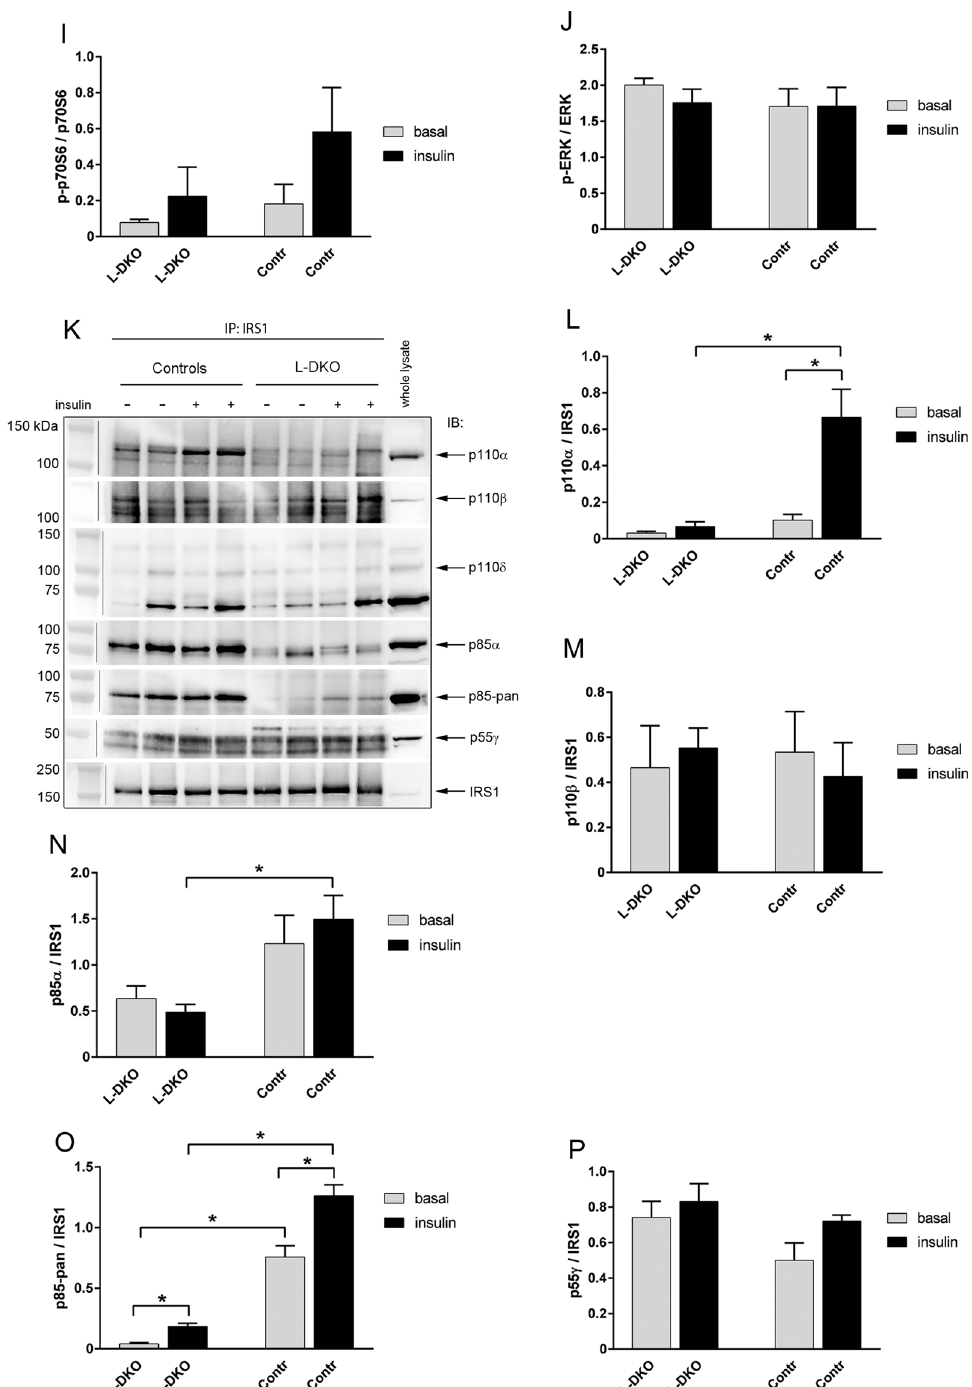
Figure 1. Gene- and protein-expression of regulatory and catalytic subunits of PI3K and associated insulin signaling mediators. mRNA expression of ( A ) Pik3ca , ( B ) Pik3cb , ( C ) Pik3r1 and ( D ) Pik3r2 in livers of flox controls and L-DKO mice. ( E ) Representative western blot of protein expression of p110 α , p110 β , p85 α , p85-pan (detects both p85 isoforms) and p55 γ . Total Akt was used as a loading control. ( F , phosphorylated Akt/PKB (Ser 473 and Thr 308), phosphorylated p70S6 kinase, and phosphorylated ERK in livers of flox controls and L-DKO mice. Total Akt, p70S6K and ERK was used as loading controls. ( G – J ) Quantification measurements of the western blots shown in ( F ) of pS-Akt, pT-Akt, p-p70S6K and p-ERK respectively. ( K ) Representative western blot of immunoprecipitation experiments with antibodies for IRS1 and subsequent immunoblotting with antibodies for p110 α , p110 β , p110 δ , p85 α , p85-pan (detects both p85 isoforms) and p55 γ . The whole-lysate reference sample was from an insulin-treated flox control mouse. ( L – P ) Quantification measurements of the western blots shown in ( K ) of p110 α , p110 β , p85 α , p85-pan and p55 γ . IP = immunoprecipitation, IB = immunoblot. Basal condition is indicated with a minus (-) sign, insulin-treated condition is indicated with a plus (+) sign. Basal conditions refer to fasting of mice overnight and injection of saline through the vena cava. Insulin treatment refers to injection of 5 U of insulin through the vena cava 5 min prior to euthanization. Error bars indicate SEM (n = 5–8). *, p < 0.05 compared to controls. n.s = non significant. Images containing a vertical line are composites taken from a single original